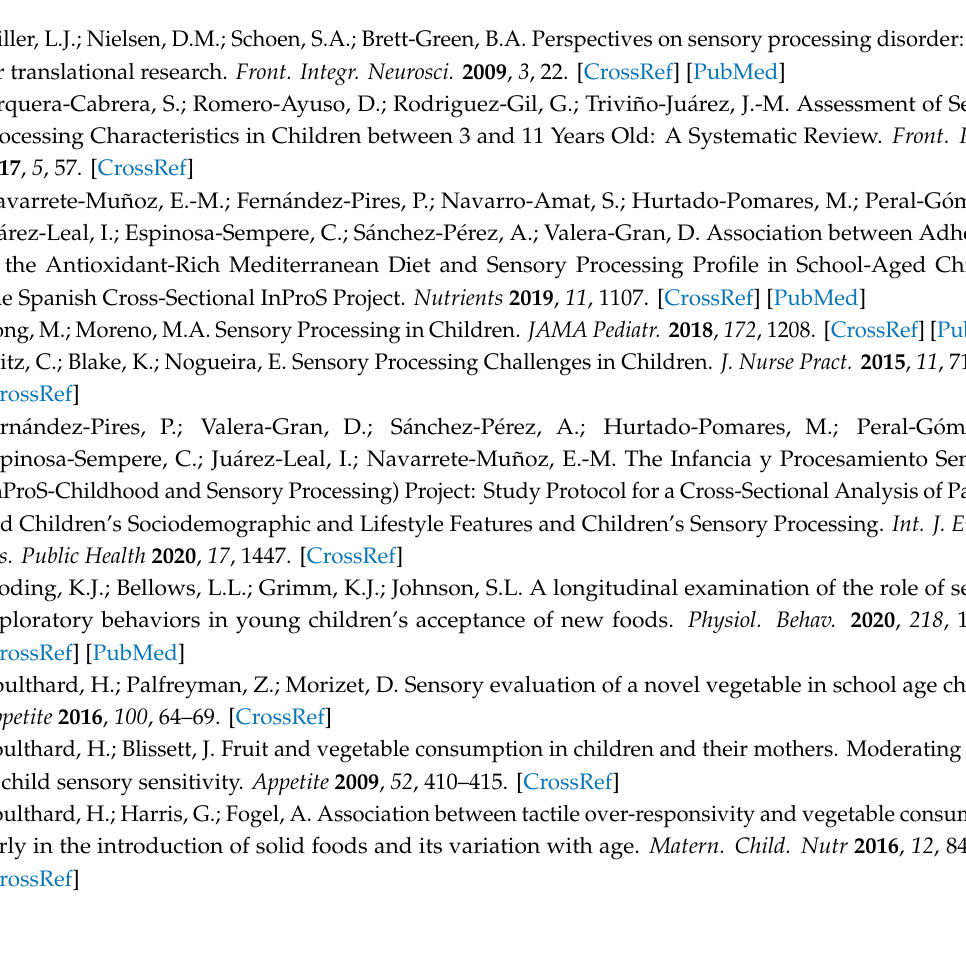
Table S1: Summary of the Short Sensory Profile